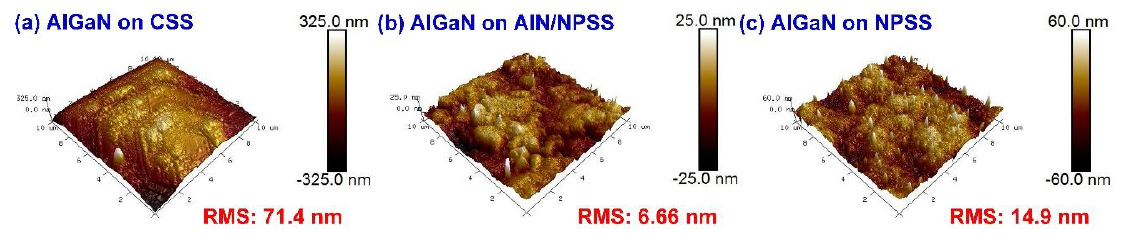
Figure 5. AFM measurements of the AlGaN grown on ( a ) CSS, ( b ) AlN/NPSS, and ( c ) NPSS [17] templates. Since the lattice constant of the AlGaN epilayer is smaller than that of the sapphire, there exists tensile strain/stress of the AlGaN layer; thus, an AlN buffer layer is commonly used to compensate the tensile stress of the AlGaN grown on a sapphire substrate template [30]. To clearly understand